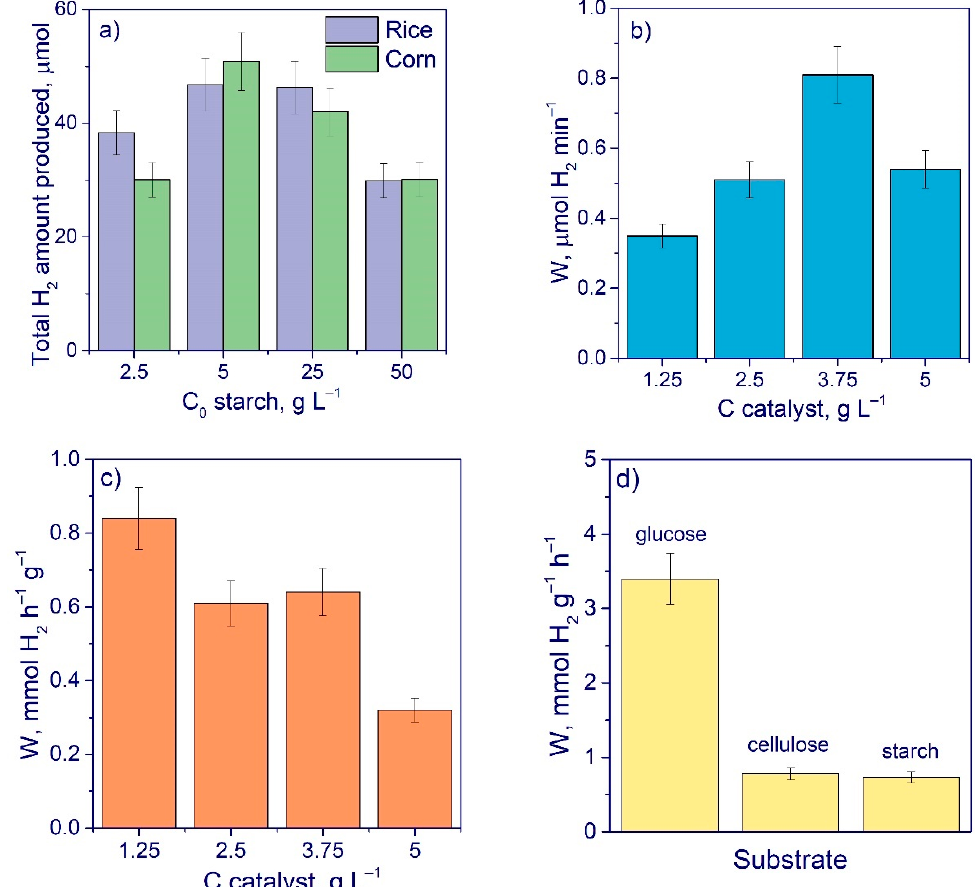
Figure 4. ( a ) The dependence of total H 2 amount on starch content; ( b ) the dependence of H 2 evolution rate on catalyst concentration, corn starch; ( c ) the dependence of specific activity on the catalyst concentration, corn starch; and ( d ) comparison of the rate of H 2 evolution from different biomass substrates over a Cd 1-x Zn x S-based photocatalyst. Conditions: C 0 (NaOH) = 5 M, C 0 (starch) = 5 g·L − 1 , C(cat) = 2.5 g·L − 1 unless otherwise stated, V = 20 mL, λ = 450 nm, t(reaction) = 120 min.